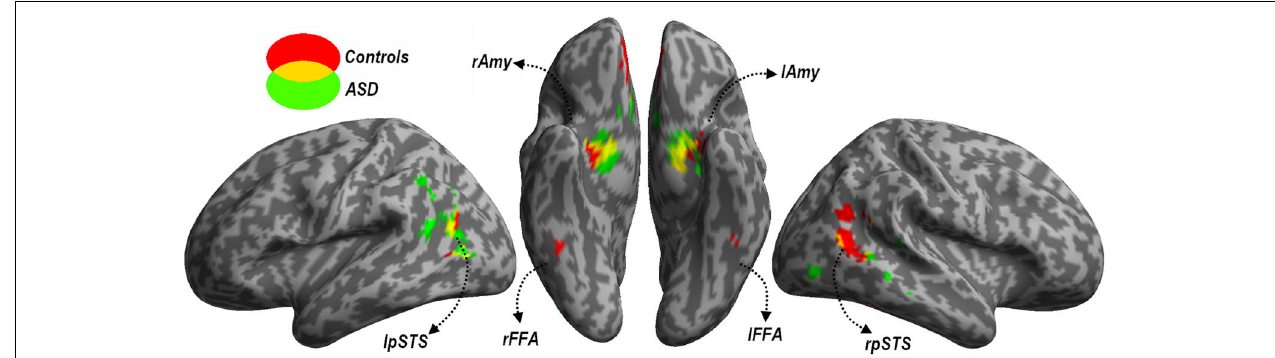
FIGURE 4 | Localizer session. Whole-brain maps showing significant increase of neural activity associated with the perception of Faces > Houses from the localizer session. Data from neurotypical participants are displayed in red, whereas data from ASD individuals are displayed in green (height threshold p < 0 . 001). Overlaps between red and green regions are displayed in yellow. Additional overlaps were seen in the fusiform cortex at lower threshold only (see main text). Activations are